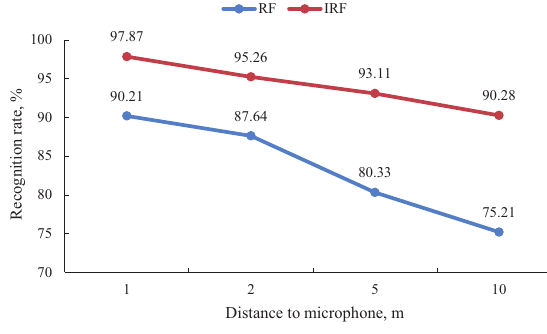
Figure 3. Comparison of UAV sound recognition rates at different distances